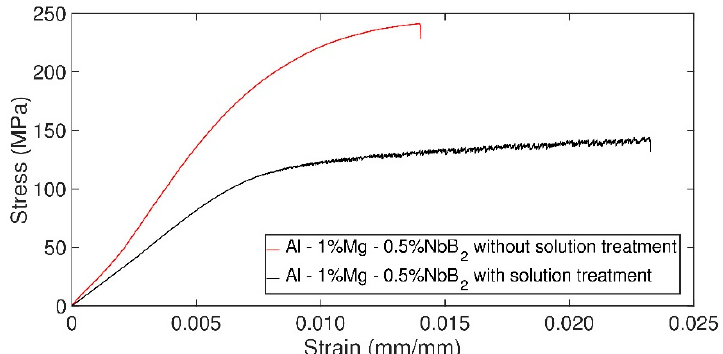
Figure 3. Tensile test curve of the aluminum wires with (red curve) and without solution treatment (black curve).